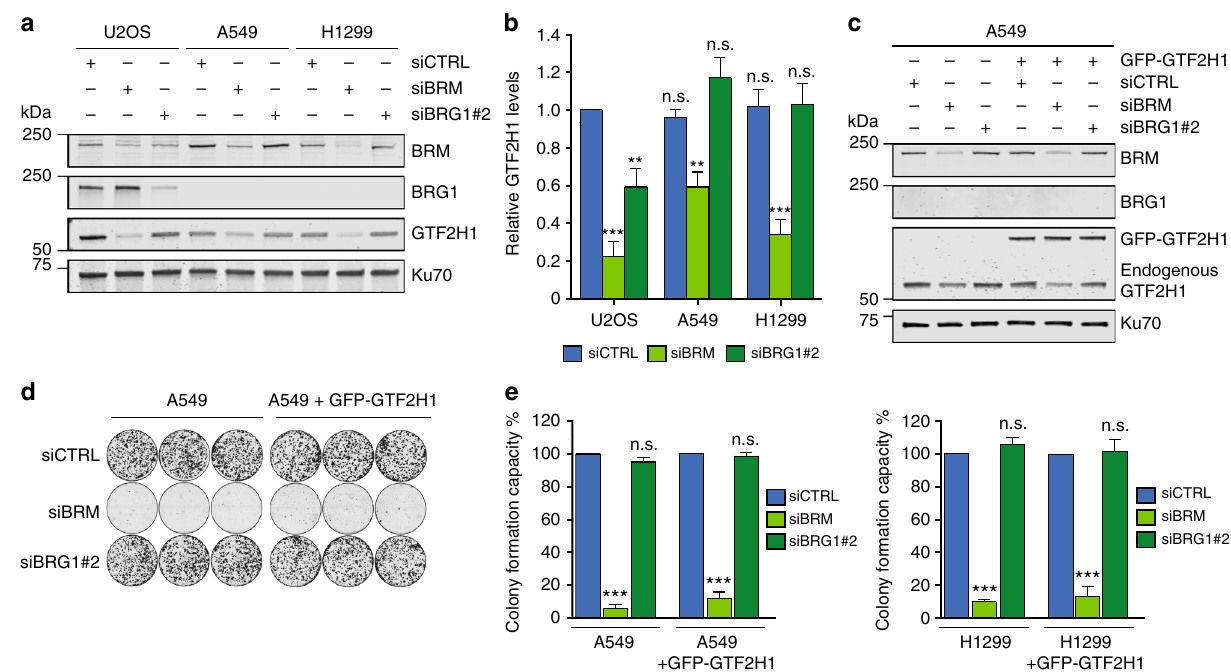
Fig. 5 Cancer cells with chronic BRG1 de fi ciency restore GTF2H1 expression. a Immunoblot showing total protein levels of BRM, BRG1, and GTF2H1, in cell lysates of U2OS and BRG1-de fi cient non-small lung cancer cell (NSCLC) lines A549 and H1299 treated with control (CTRL), BRG1 or BRM siRNAs. Ku70 was used as loading control. b Relative quanti fi cation of GTF2H1 protein levels in U2OS, A549, and H1299 cells transfected with control (CTRL), BRG1 or BRM siRNA. GTF2H1 levels were normalized to Ku70 and the total relative amount of GTF2H1 in whole cell lysates was set to 1.0 in U2OS siCTRL. Mean & S.E.M. from at least three independent experiments ** P < 0.01, *** P < 0.001, n.s., non-signi fi cant. c A549 cells with and without stable expression of GFP- GTF2H1, driven by the ectopic PGK promoter, were treated with control (CTRL), BRM or BRG1 siRNAs. Cell lysates were analyzed by